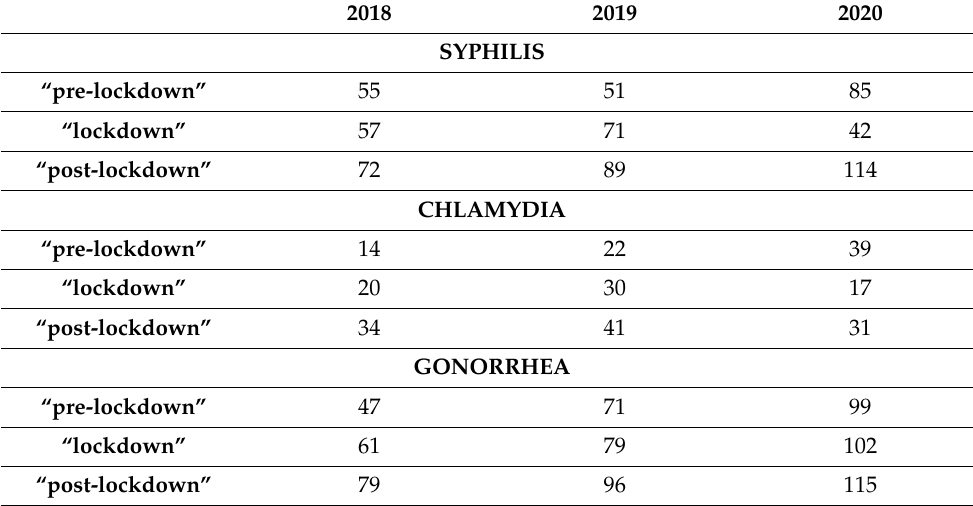
Table A1. The overall number of syphilis, chlamydia, and gonorrhea in the “pre-lockdown”